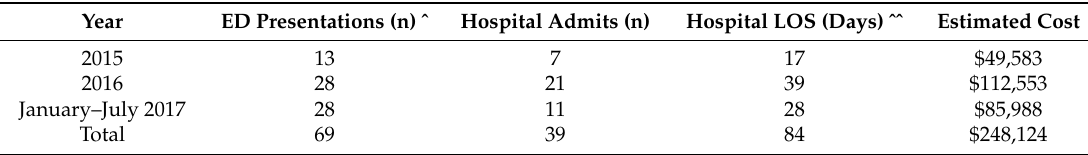
Table 2. Case 2: Hospital presentations and admissions (January 2015–July